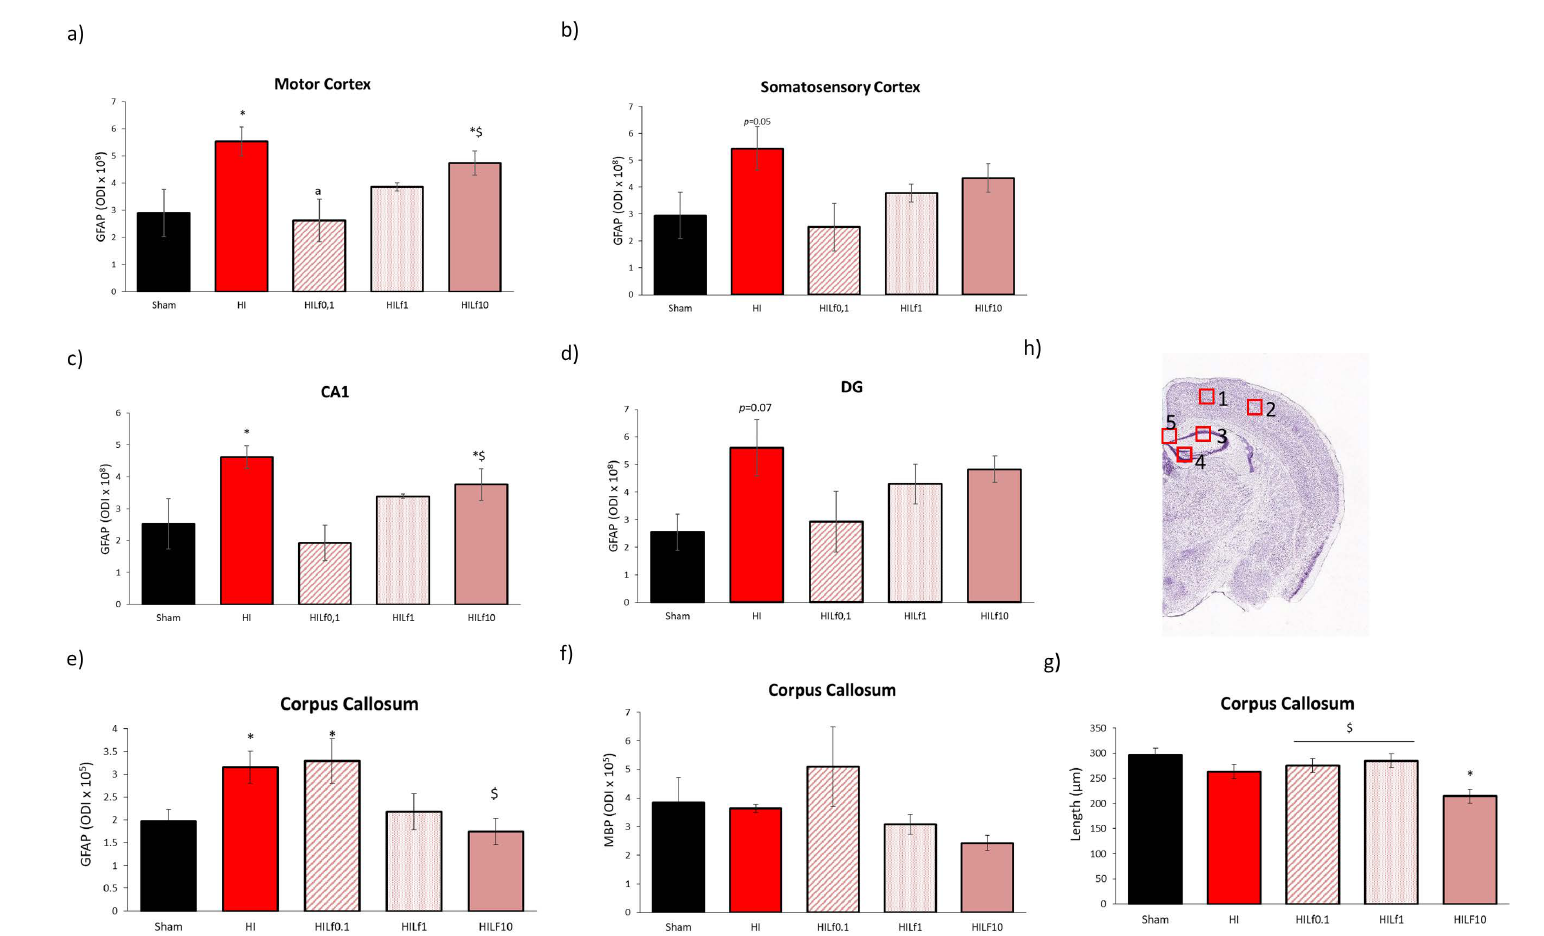
Figure 6. Effects of Lf and HI on brain tissue at P25. Optical density intensity (ODI) of astrocytes (GFAP) in the motor cortex ( a ), somatosensory cortex ( b ), CA1 ( c ), dentate gyrus ( d ), and corpus callosum ( e ). Assessment of myelination (MBP) and thickness ( f , g ) of the corpus callosum CC using 30 µ m brain slices at the dorsal hippocampus level. Representative image of the brain regions assessed ( h ). Scale bar 100 µ m. * HI vs. SH, $ difference between HILf groups. a HILf0.1 vs. HI, respectively. Differences were determined by one-way ANOVA and considered significant when p < 0.05 ( n = 3–5